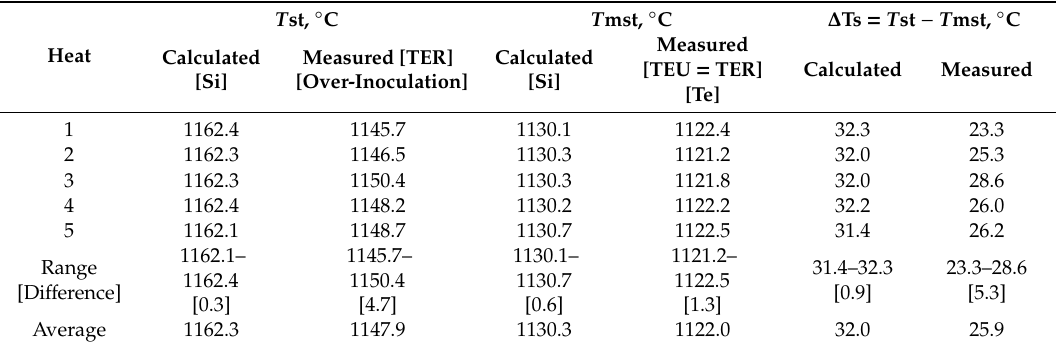
Table 4. Calculated and measured T st and T mst eutectic temperatures of cast